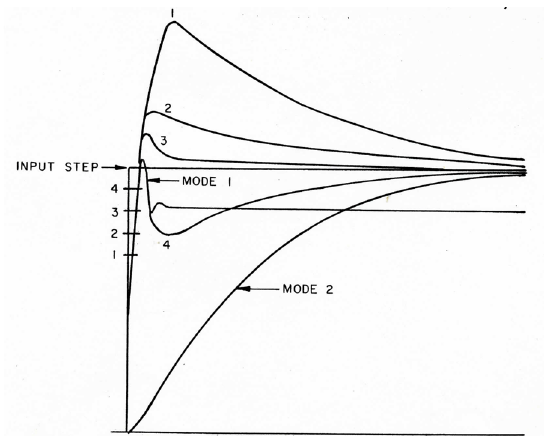
Figure 4. Illustrations of the effects of different switching times on the step response of the dual-mode system. From (Mantgiaris,